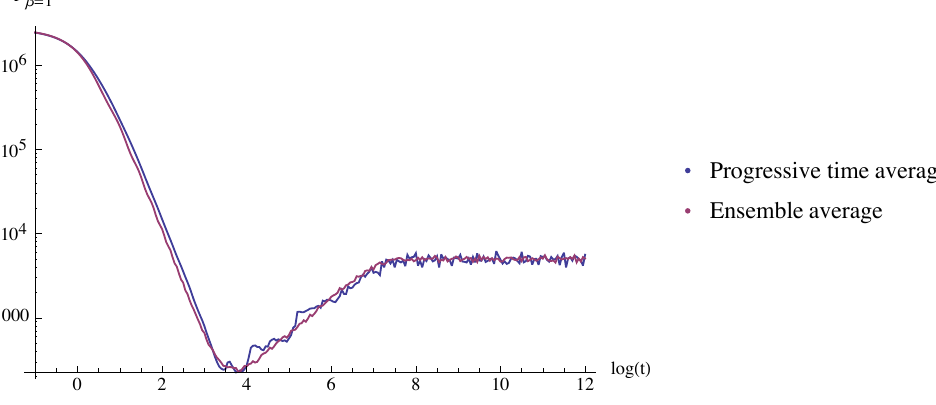
Figure 4 . Log-log plot of the average spectral form factor with (cid:12) = 1 for (cid:12)ve hundred 1024 (cid:2) 1024 matrices drawn from the Gaussian unitary ensemble (GUE) (purple), and the sliding window aver- age (3.9) for a progressive time window (cid:1) t = 0 : 8 t (blue) for a single instance of a random matrix. The progressive window captures the behavior of the ensemble average, in particular the dip, the ramp and the